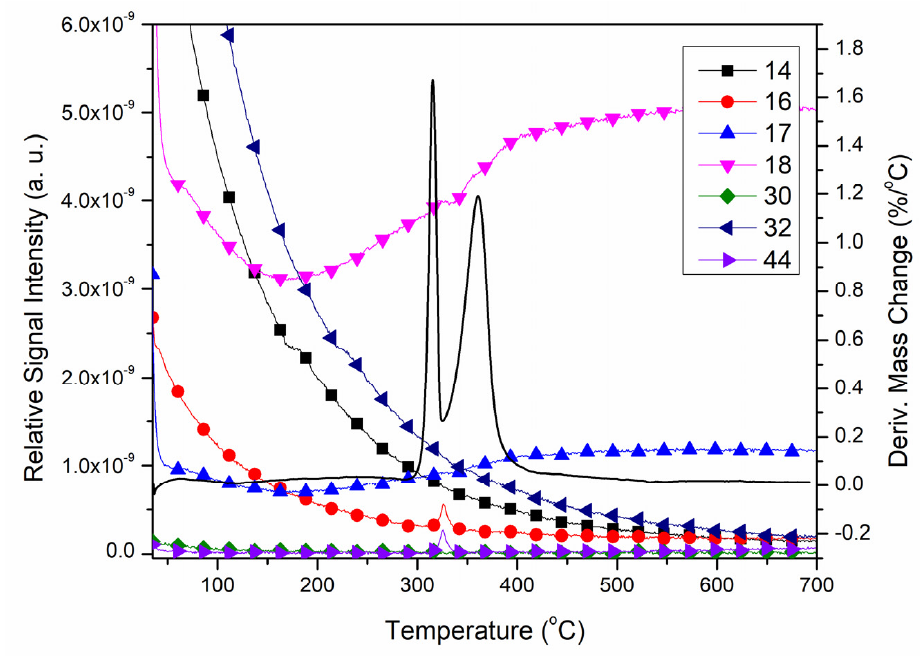
Figure 7. TG–MS signals of fragments evolved from 1 during heating in argon.